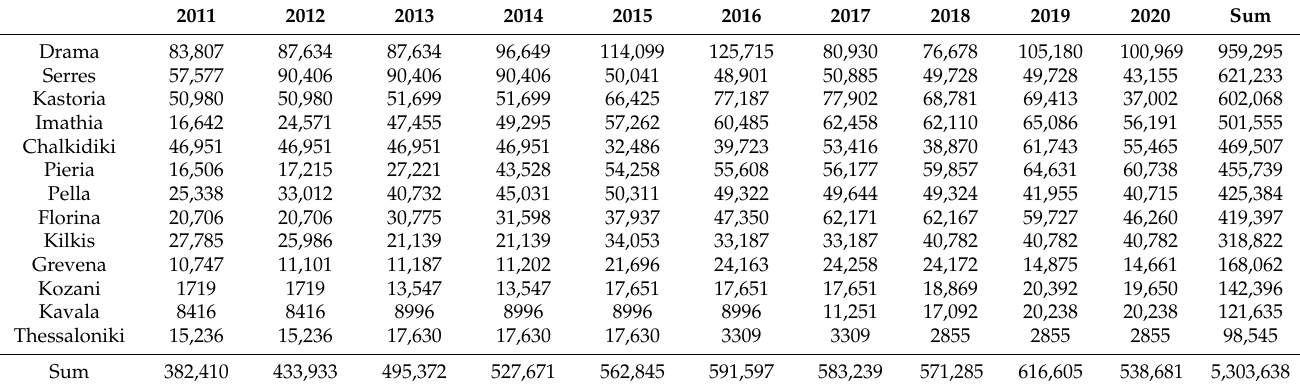
Table A3. Estimated timber volume extracted from forest district management for the period 2011–2020 in cubic meters, grouped per year and for each of the 13 prefectures of Macedonia,